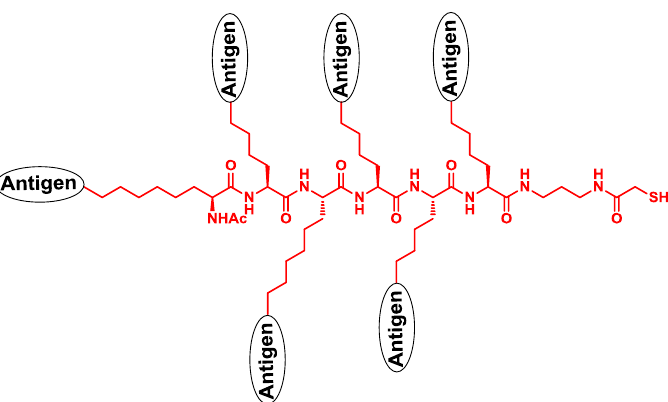
Figure 5. The structure of a linear multivalent